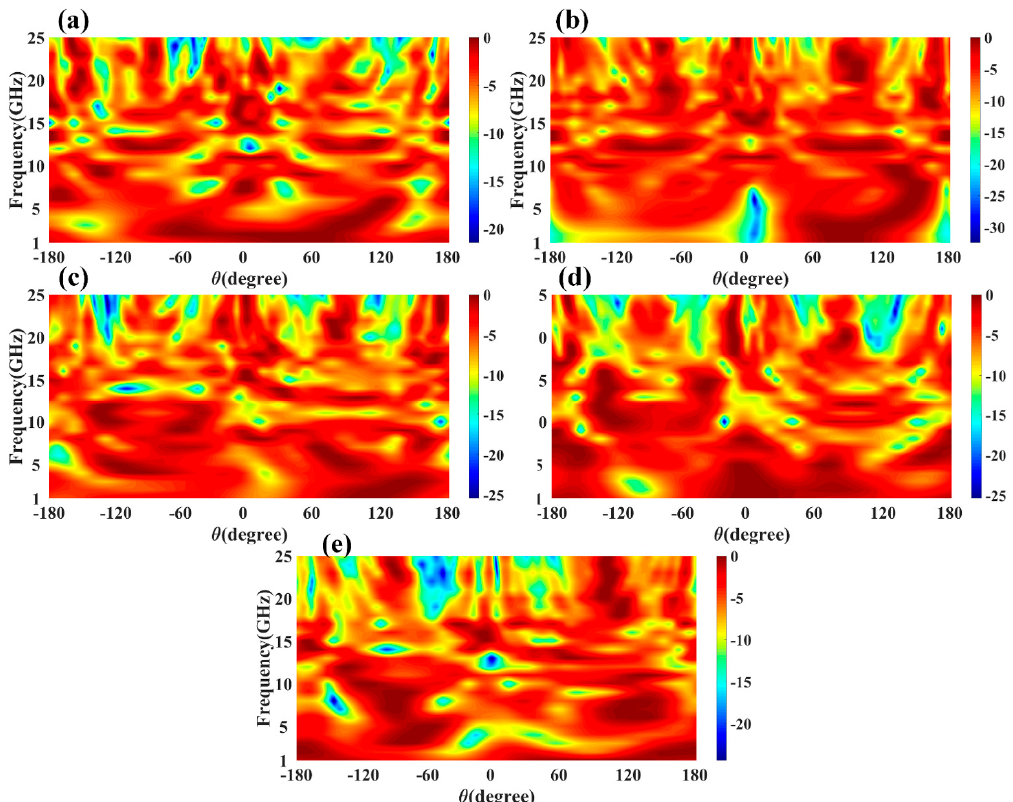
Figure 6. Calculated variation in normalized gain (dBi) for the different polar angles and frequency spectrums. Variation in gain for the different ( a ) design 1, ( b ) design 2, ( c ) design 3, ( d ) design 4, and ( e ) design 5 antennas.